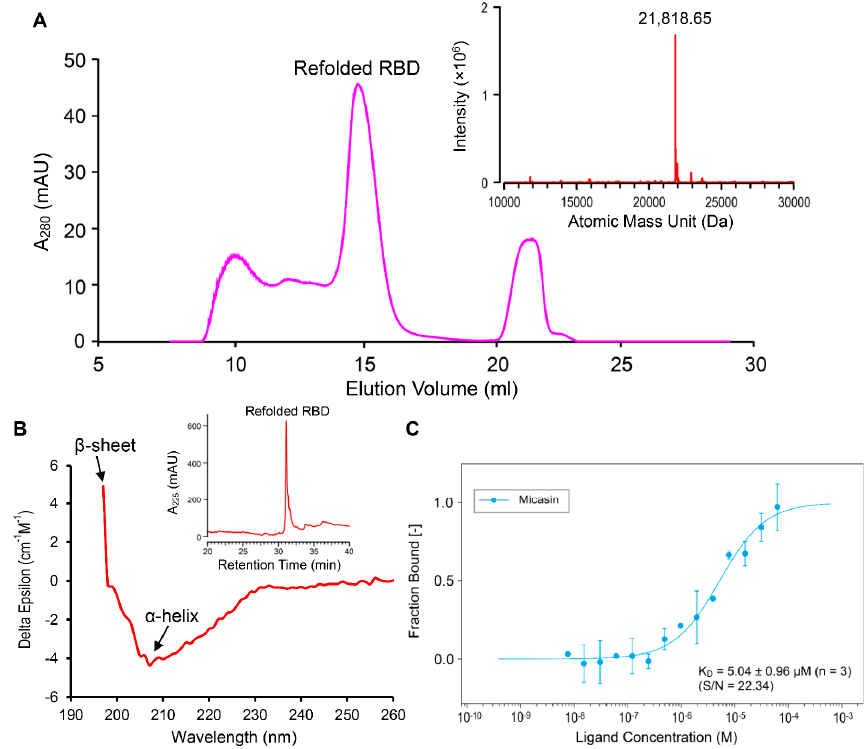
Figure 3. Purification and identification of recombinant RBD and quantification of its binding affin- ity to NT − 495 − labelled RBD by microscale thermophoresis (MST). ( A ) Purification of the refolded RBD by SEC. Inset: HPLC − Q − TOF − MS determining the molecular mass. ( B ) CD spectra. Spectral absorbance signatures for β− sheet (a positive maximum at 197 nm) and α− helix (a negative mini- mum at ~208 nm) are denoted by arrows. Inset: RP − HPLC analysis of the RBD collected from SEC for the detection of its conformational homogeneity. ( C ) The dose − response curve for interactions. Data points derived from the MST traces on the hot region of 20 s indicate the bound fraction gen- erated from the normalized fluorescence (‰) based on fluorescent RBD or the fluorescent RBD and peptide complex against the ligand concentration, from which a dose − response curve was fitted with the K D model for calculation of the binding affinity. Error bars are standard deviations (SDs) from three independent measurements. The experiments were performed at 25 °C at high MST and 20% LED power. S/N, signal − to − noise ratio.